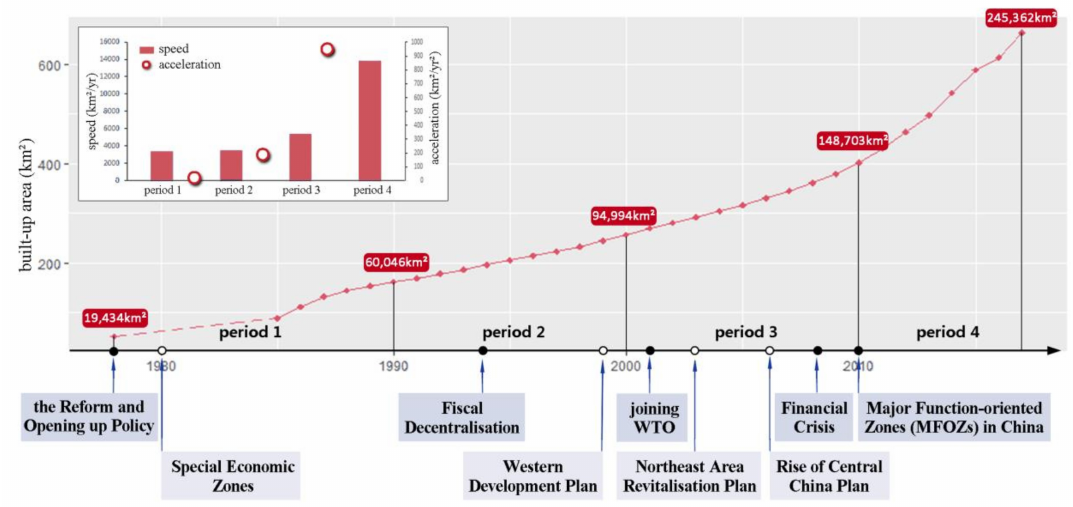
Figure 6. Built-up area expansion in China between 1978 and 2017.